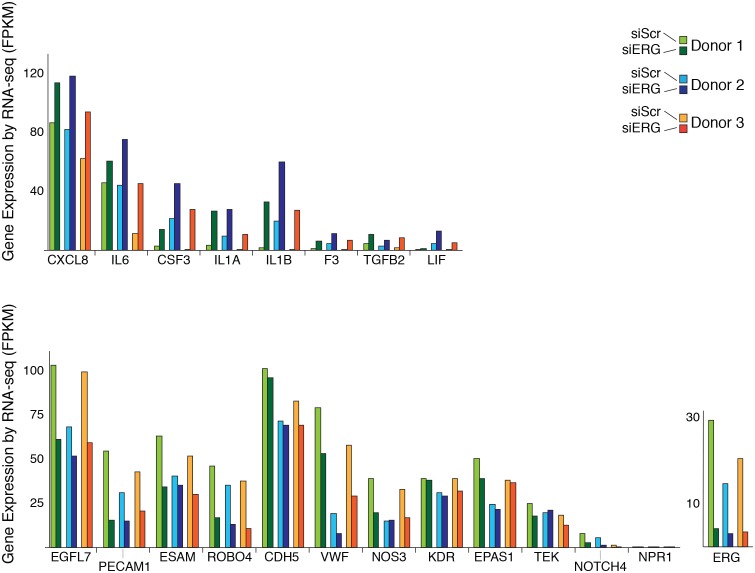
Changes in gene expression with ERG knockdown measured by RNA-seq.Gene expression levels of various genes according to RNA-seq data in three different donors, each in control (siSCR) and ERG knockdown (siERG) conditions.